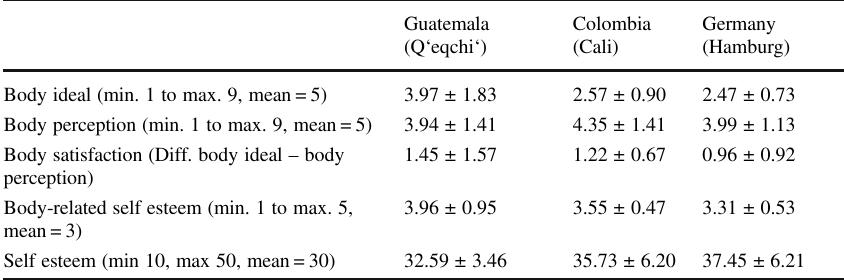
Table 3 Results of the survey on body ideal, body perception and body satisfaction using the Figure Rating-Scale (Mean values ± SD)